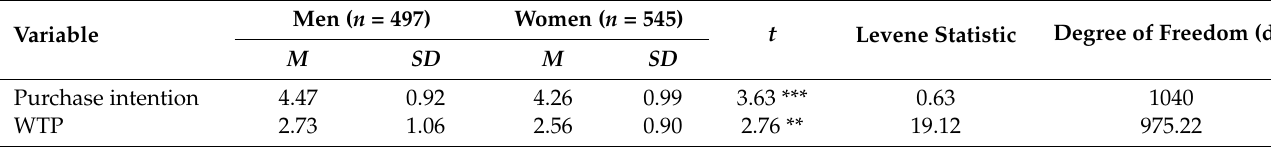
Table 5. Independent samples t test for gender ( n = 1042).